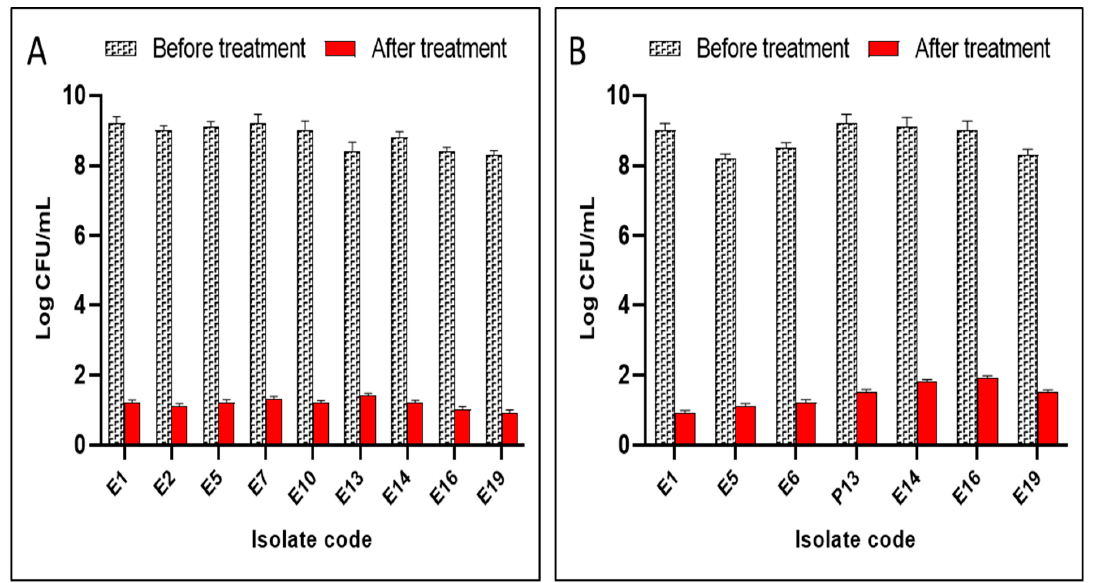
Figure 7. E ff ects of ( A ) hyperoside and ( B ) canavanine on the count of CFU/mL of the bio fi lm-form- ing bacterial cells. bacterial